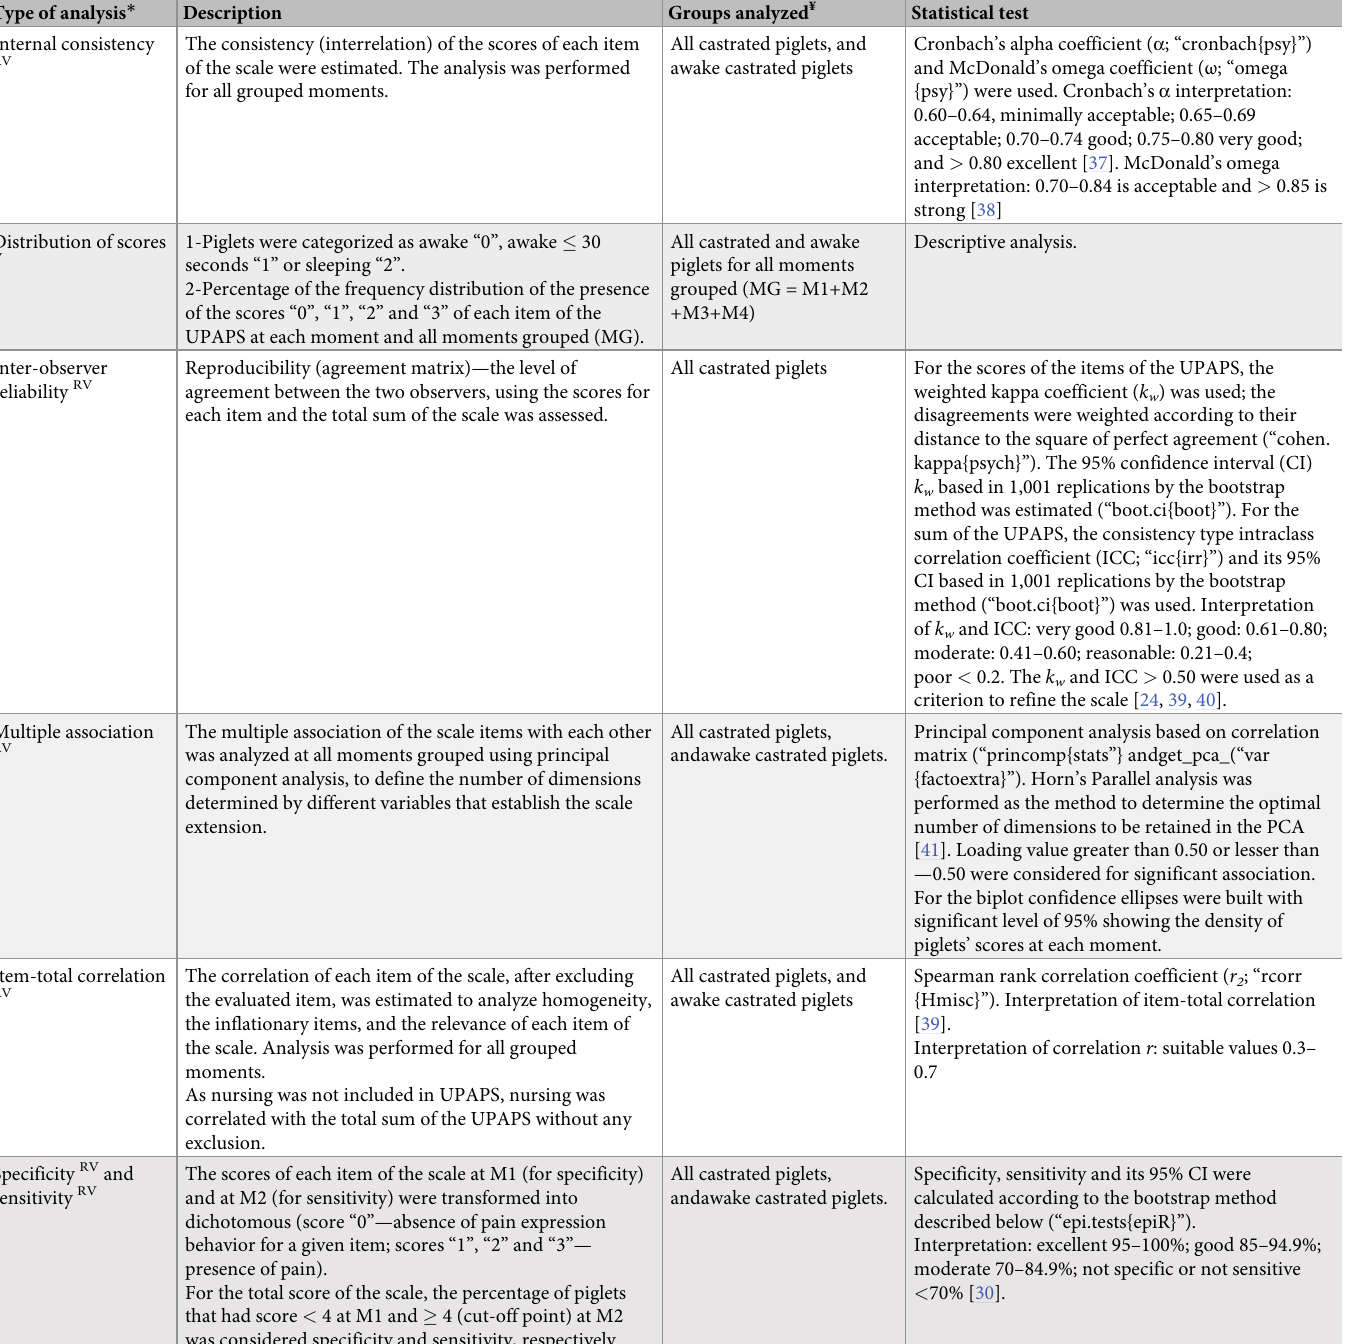
Table 2. Statistical methods used for refinement ( R ) and validation ( V ) of the Unesp-Botucatu pig acute pain scale (UPAPS) in the piglets